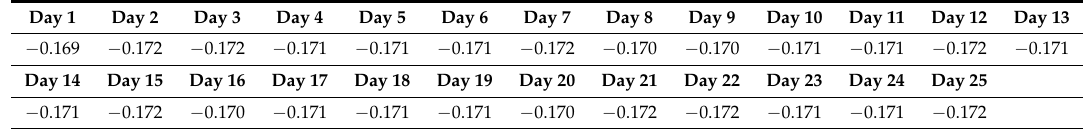
Table 5. Mean (M) values of normal state.